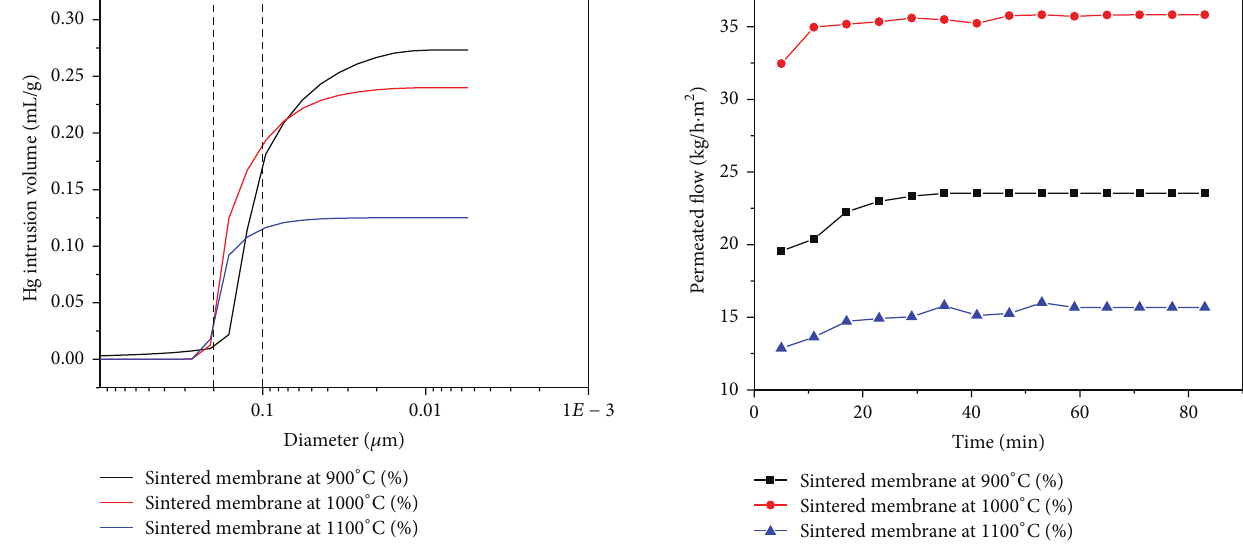
Figure 5: Distilled water permeated flows to the ceramic mem- branes sintered at 900, 1000, and 1100 ∘ C.